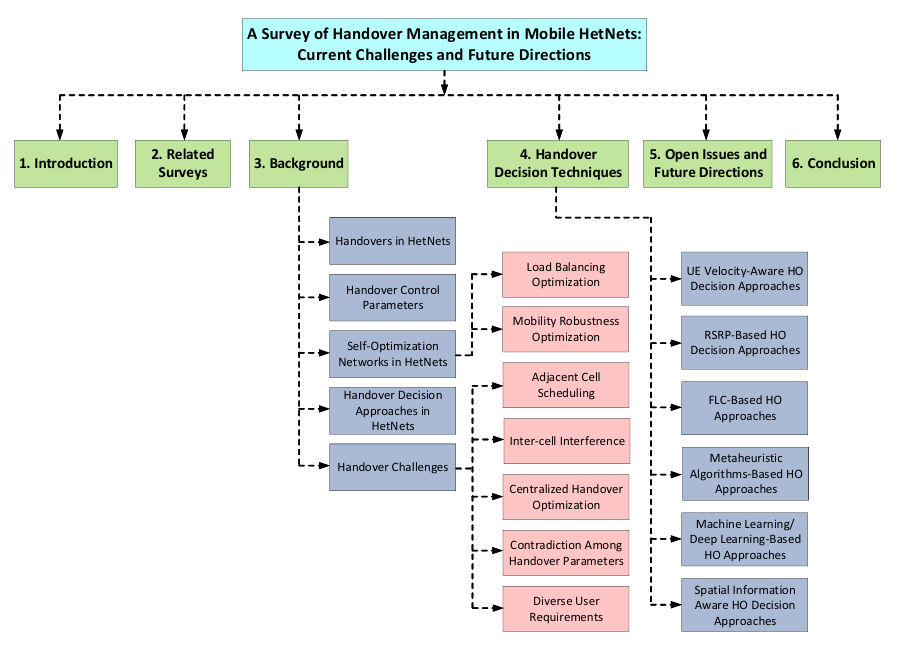
Figure 2. Outline of the